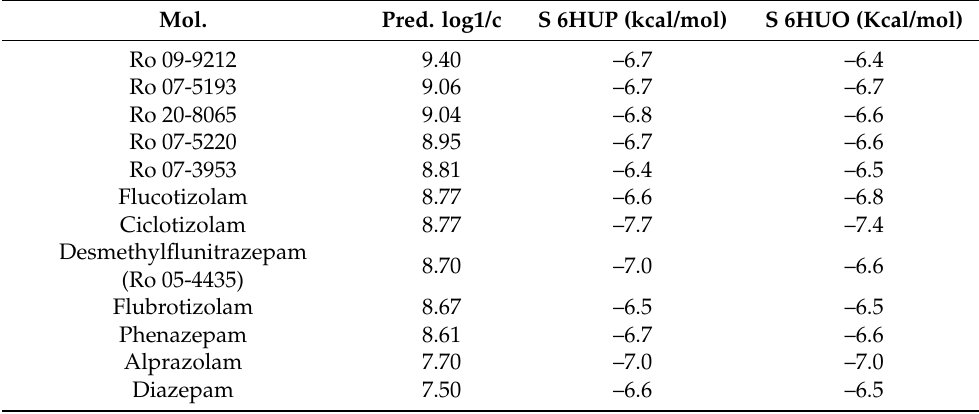
Table 3. Binding values S (kcal/mol) were generated for the ten molecules that showed the highest predicted values of log1/c (nM), docked within the two receptors 6HUP and 6HUO. Notes: The molecules are listed in decreasing order of their predicted log1/c (biological activity); alprazolam and diazepam are prescription medications and here included only as a reference because they are the respective bound ligands of 6HUO and